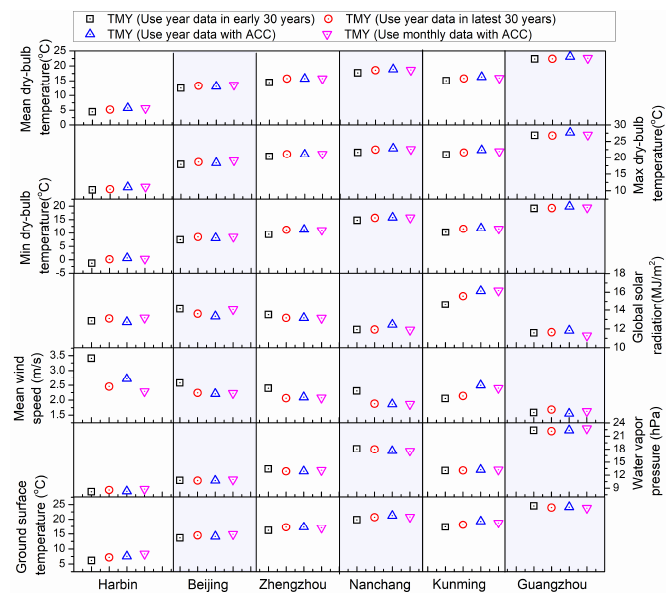
Figure 7. Compare the di ff erence of TMY considering ACC or not.